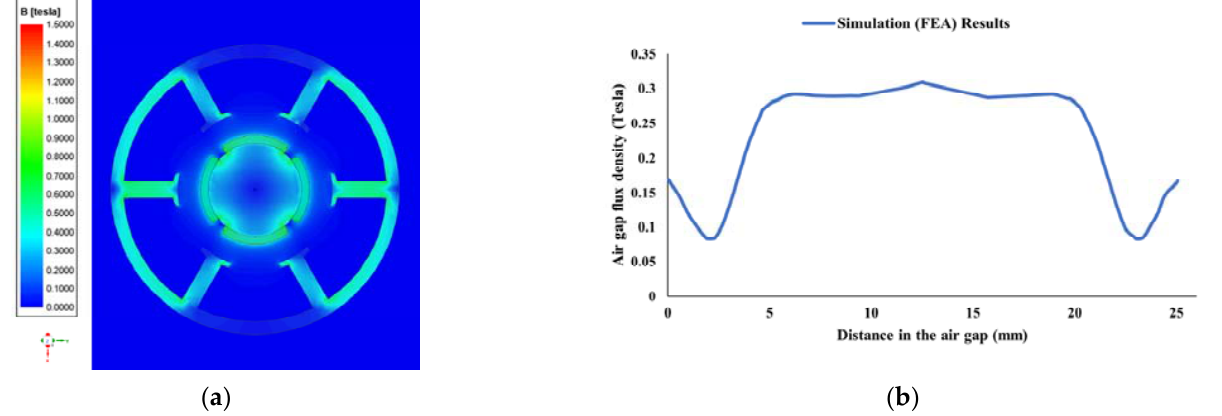
Figure 7. Magnetic field distributions in the air gap of the motor under no ‐ load conditions: ( a ) magnetic field distribution in the air gap from the top view of the motor; ( b ) magnetic field distribution in the air gap of the motor.